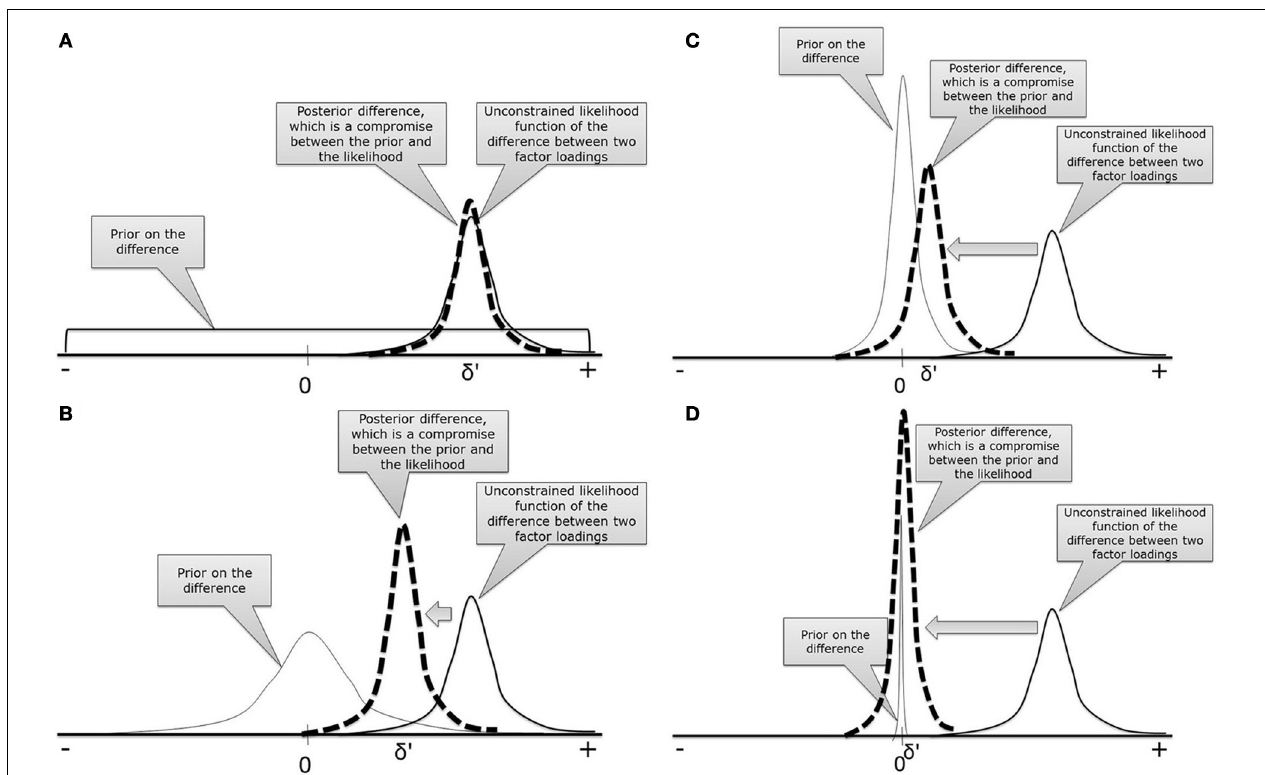
FIGURE 3 | Four different prior distributions to demonstrate the influence of the prior on the posterior parameter estimates. (A) Uninformative prior; (B) Wide normal prior; (C) Narrow normal prior; (D) Highly peaked